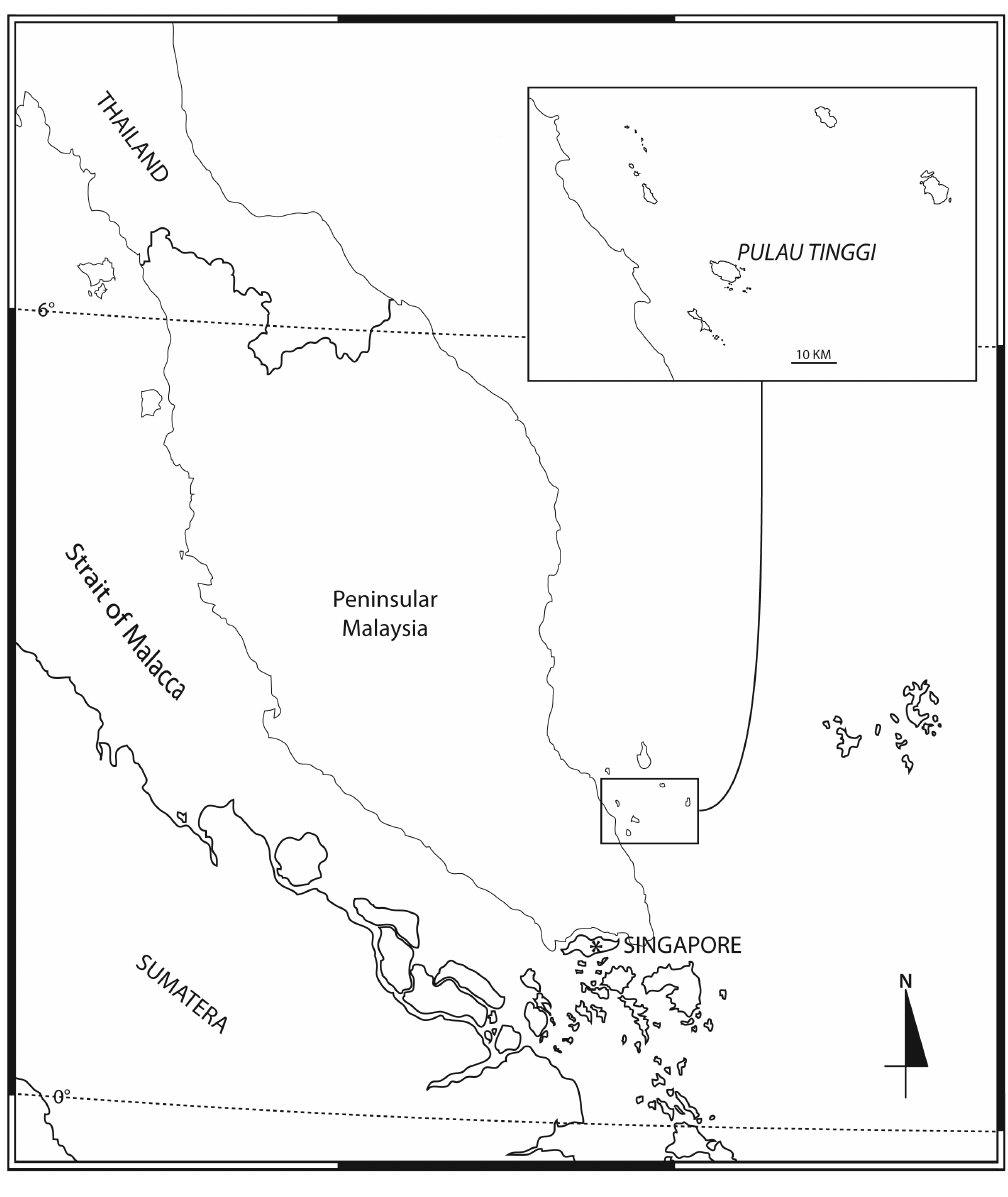
Figure 1. Pulau Tinggi, Johor, Malaysia.